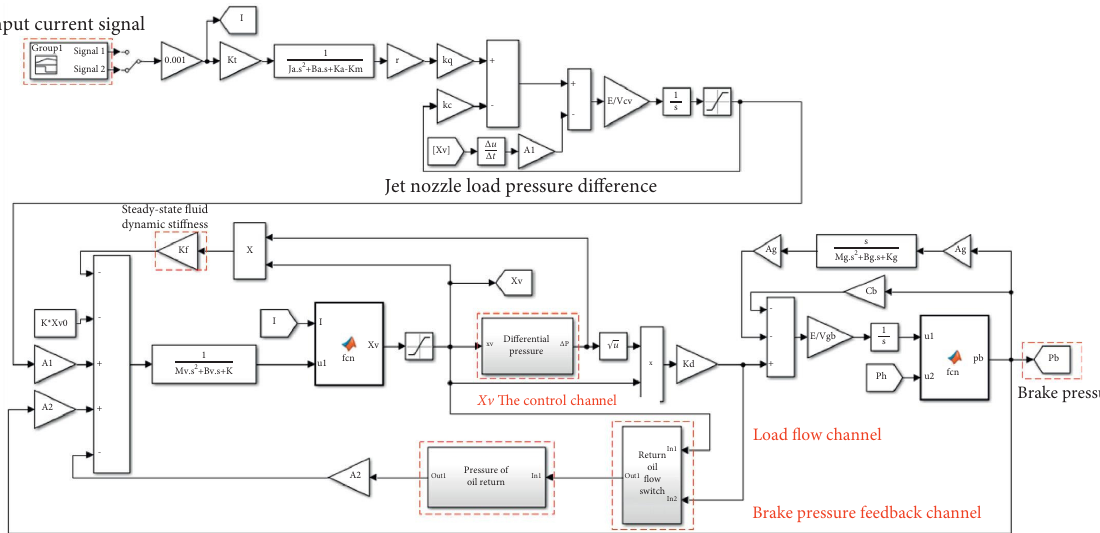
Figure 11: MATLAB/Simulink model of brake pressure servo valve-controlled cylinder system.